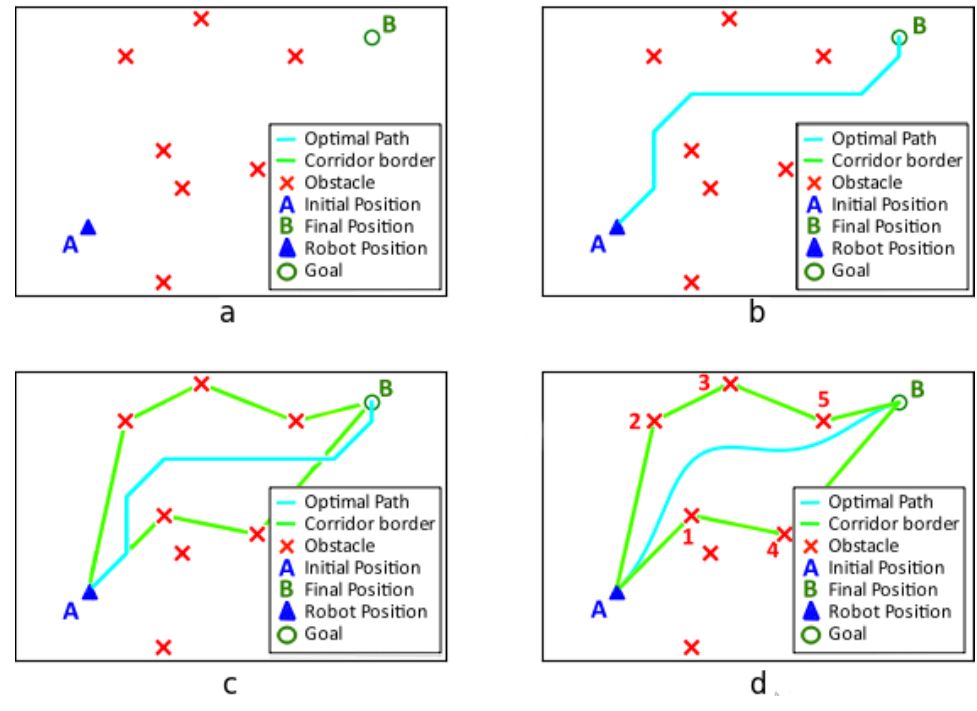
Figure 7. Steps of the Adapted Bézier Curve